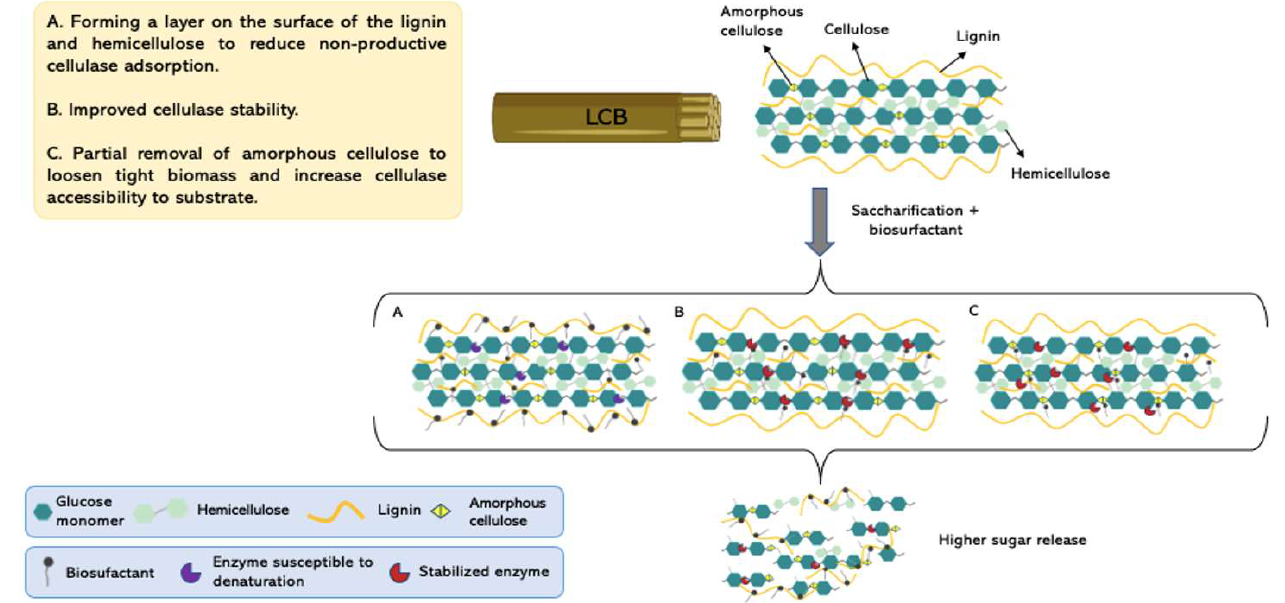
Figure 1. Underlying mechanisms of action of biosurfactants on pretreated lignocellulosic biomass and their effects during enzymatic hydrolysis (Created with BioRender.com).